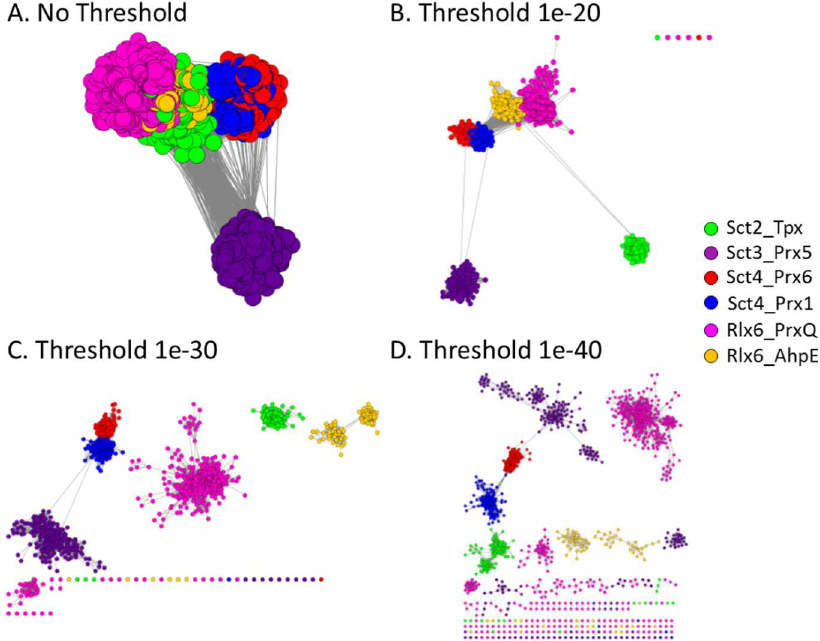
Fig 11. Representative network highlights sequential similarity between Sct4_Prx1 and Sct4_Prx6 MISST groups. A representative network shows all proteins identifiedby the six MISST groups, with one representative per 55% sequentially identicalcluster. The nodes in the representative network are colored by MISST group (see legend),and the edgesrepresent pairwiseBLAST scores betweenthe representative proteins. The network is shown with no edge value threshold(A), and e-value thresholds of 1e-20 (B), 1e-30 (C), and 1e-40 (D), where all edgeswith scores greater than the thresholdare removedprior to applyingthe force-directed layout. Network visualizations were created with